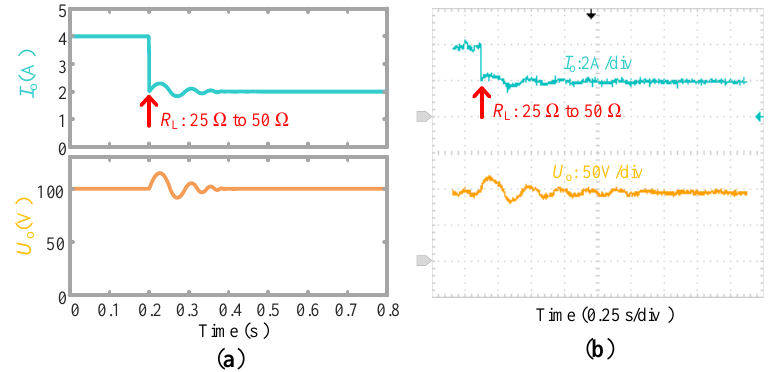
Figure 11. Simulated and experimental CC power transfer results of DPC system: ( a ) simulated; and ( b ) experimental. I o , output current (blue lines); U o , output voltage (green lines).